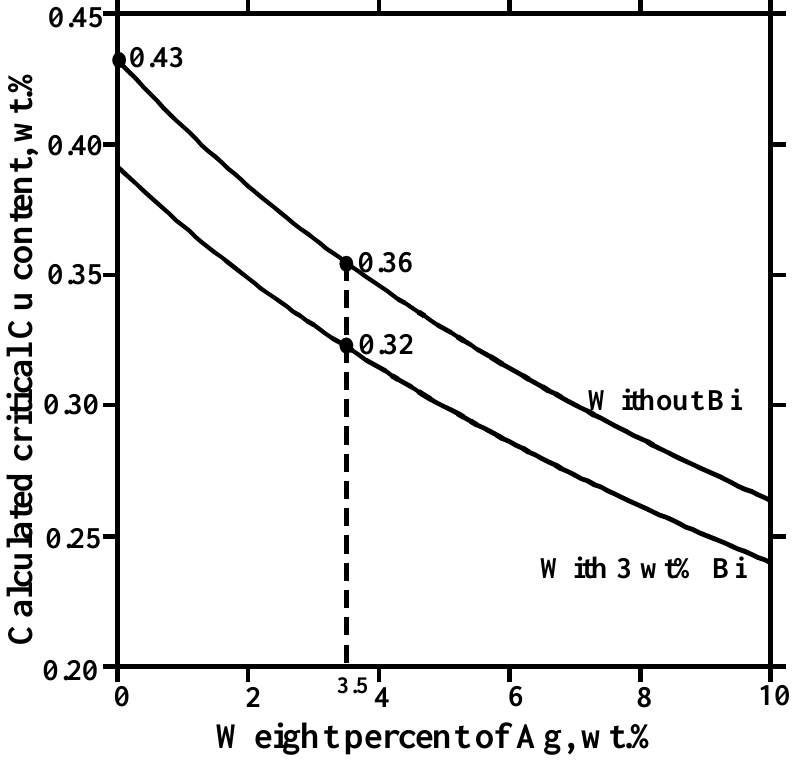
Figure 13. Effect of alloying Ag and Bi to Sn on the critical Cu content at T = 250